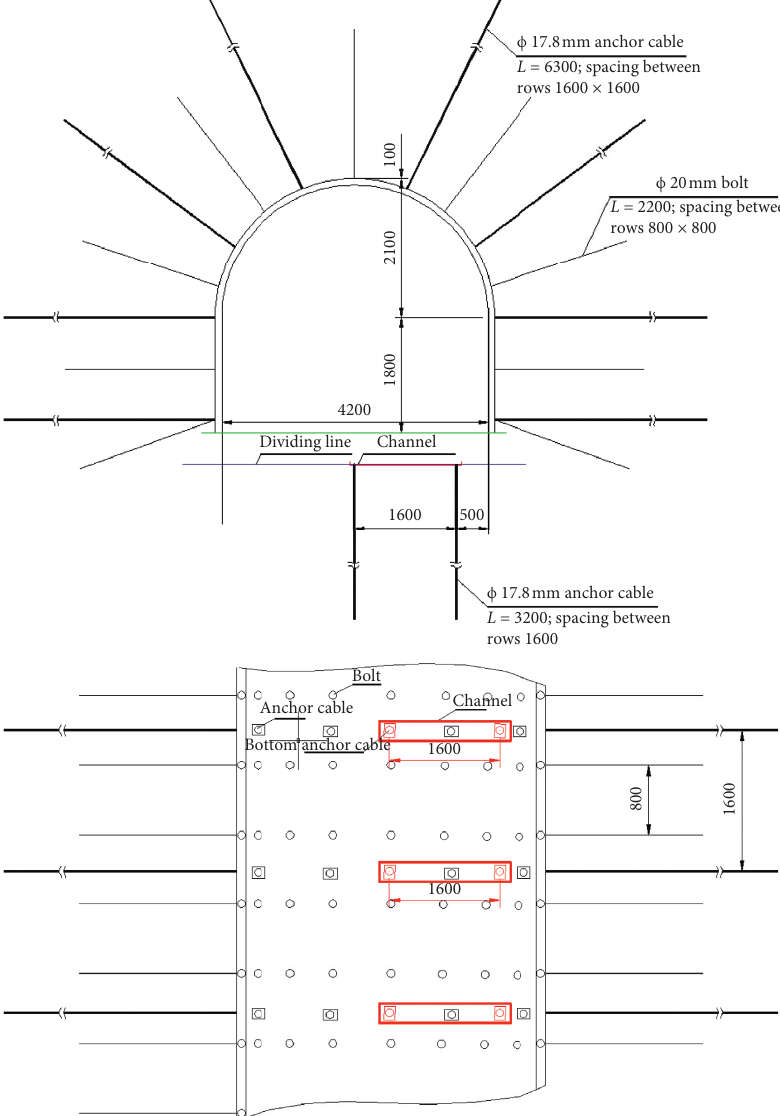
Figure 16: The diagram of the section support.